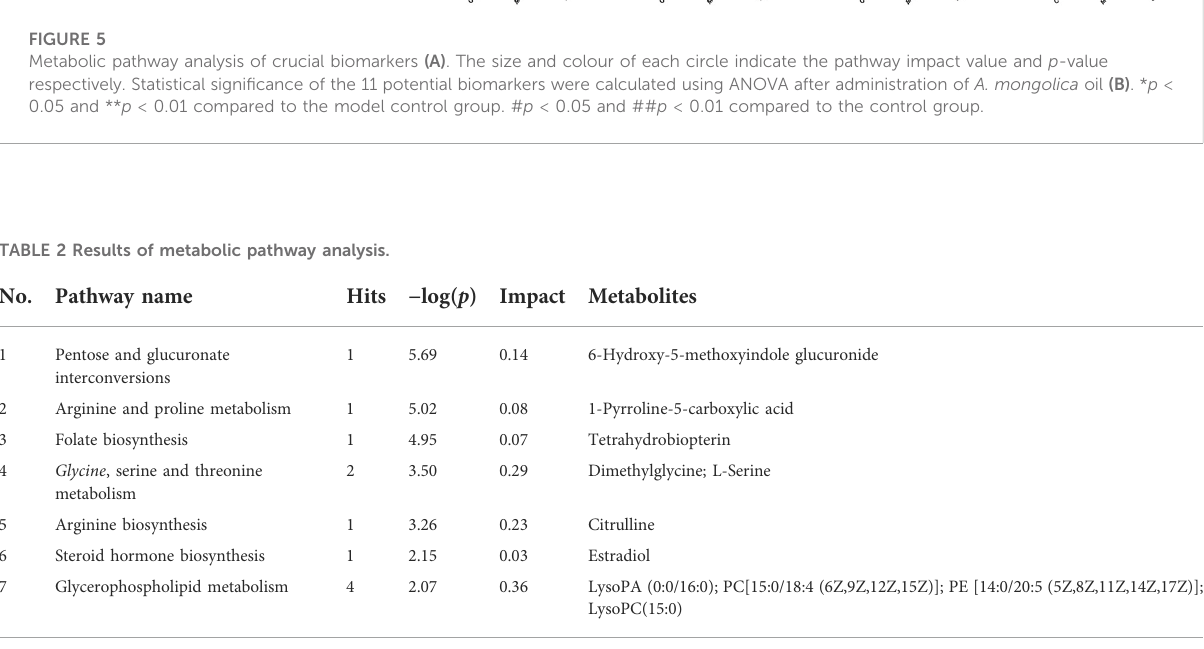
Figure 7A. There